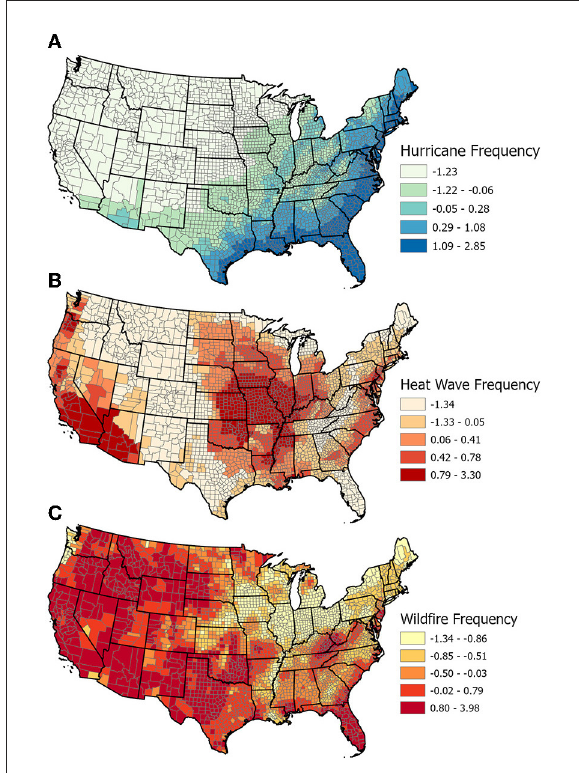
FIGURE3 Z- scores of (A) hurricane frequency, (B) heat wave frequency, and (C) wildfire probability (FEMA., 2020). Counties are grouped and color-coded in